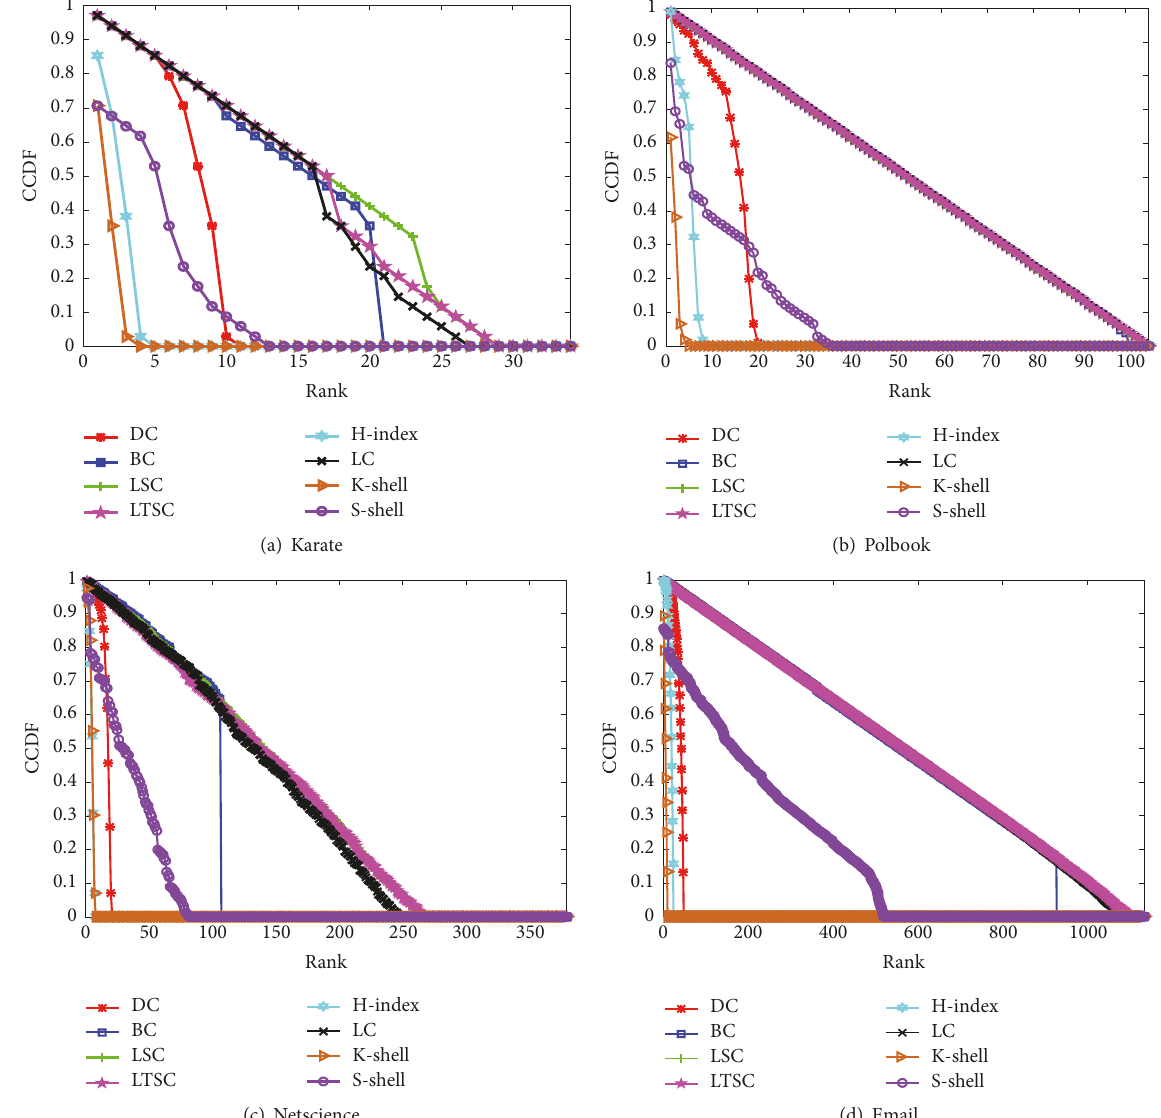
Figure 2: 𝐶𝐶𝐷𝐹 curves are plotted to rank the importance of nodes in Karate, Polbook, Netscience, and Email networks. to verify the discriminability: One is that the size of nodes and edges of the four networks are from tens to thousands of nodes. And the other reason is that there are obvious communities and central nodes in them. LTSC achieves a better rank distribution performance compared with the other indexes. It shows a slowdown trend in the four panels and has similar variant behaviors with LC, LSC, and BC.